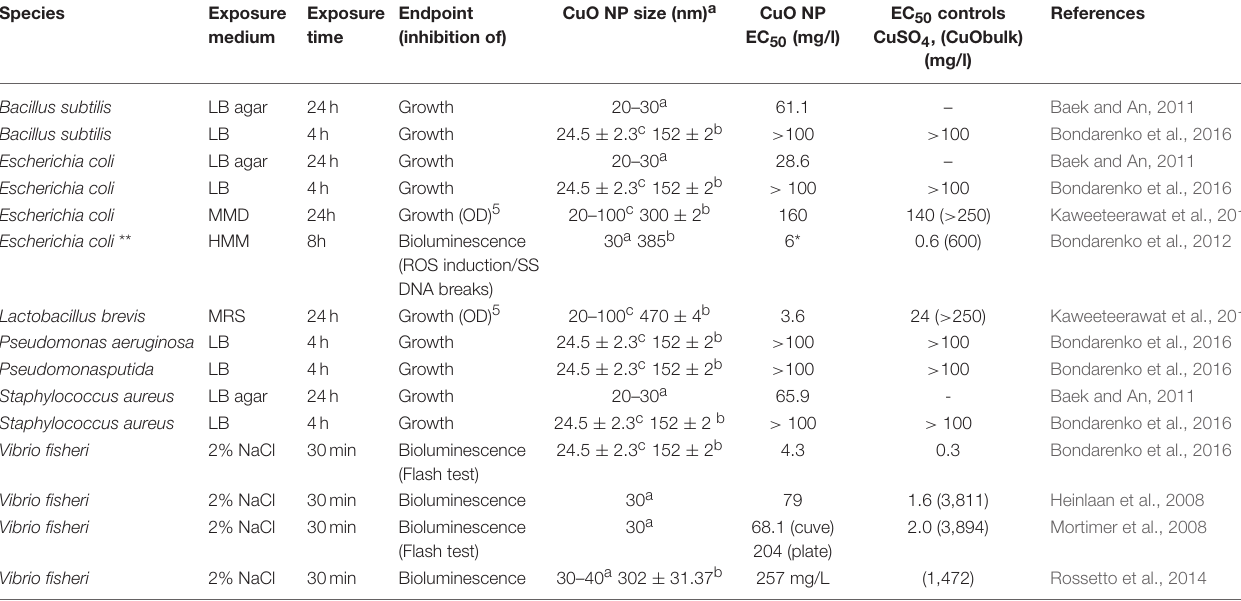
TABLE 3 | Comparison of EC 50 and/or main results obtained for short- and long-term exposures to copper oxide nanoparticles (CuO NPs) on different bacterial species.